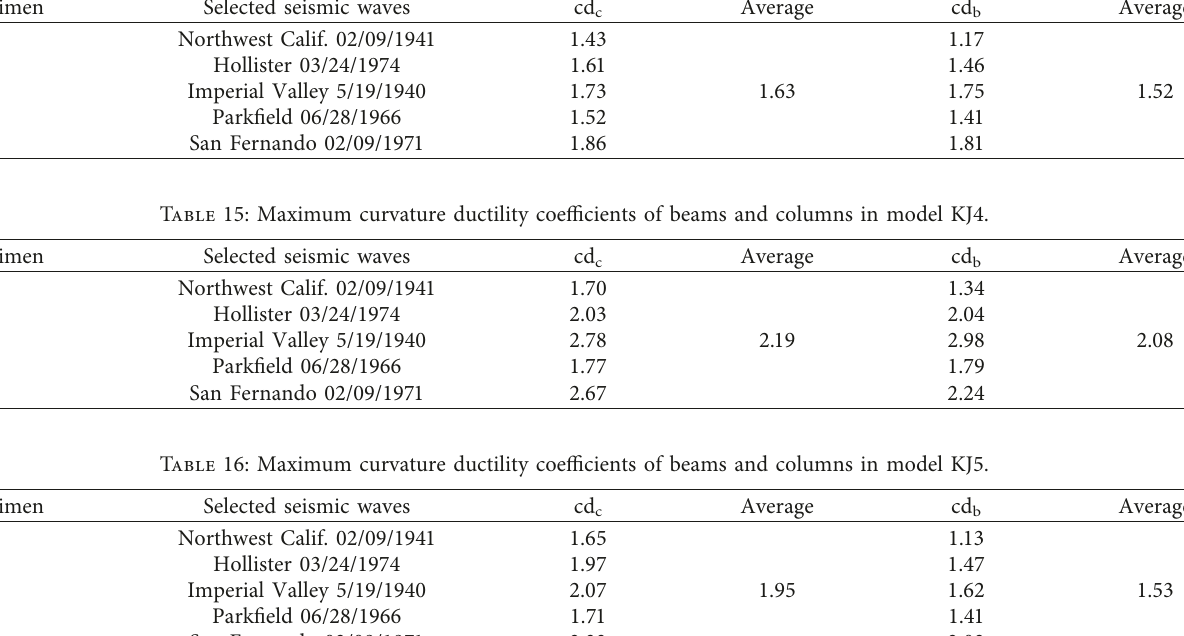
Table 14: Maximum curvature ductility coefficients of beams and columns in model KJ3. Specimen